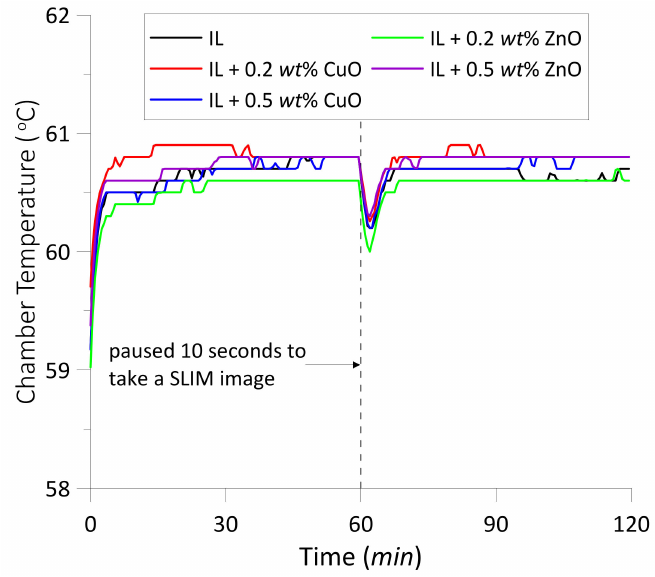
Figure 3. The variation of chamber temperatures during the wear